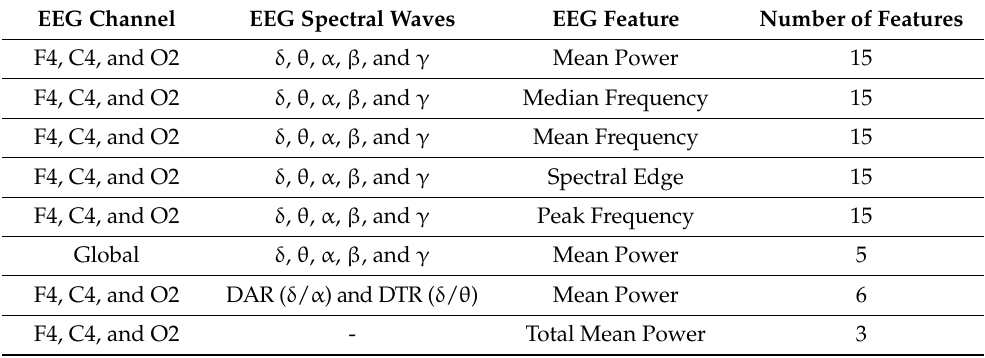
Table 1. Features extracted from the EEG signal. The Global channel is averaged over F4, C4, and O2